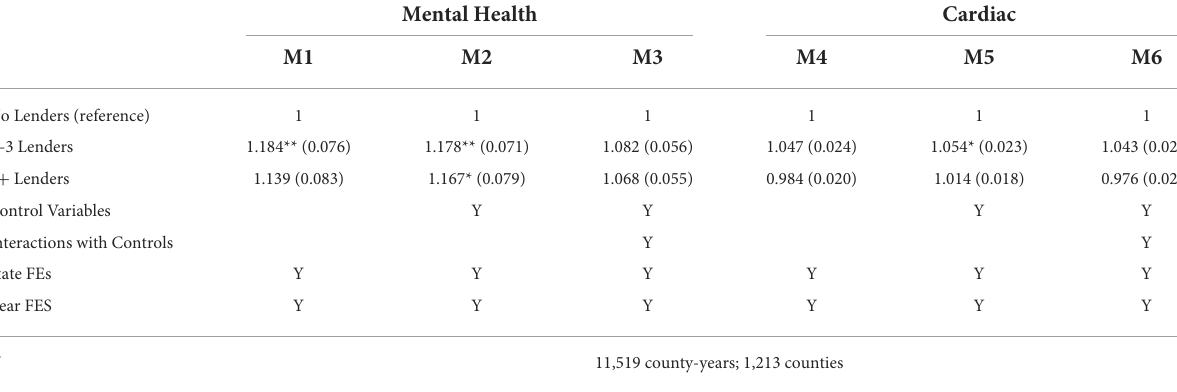
TABLE 3A Incidence risk ratios for premature deaths from mental health and cardiac-related